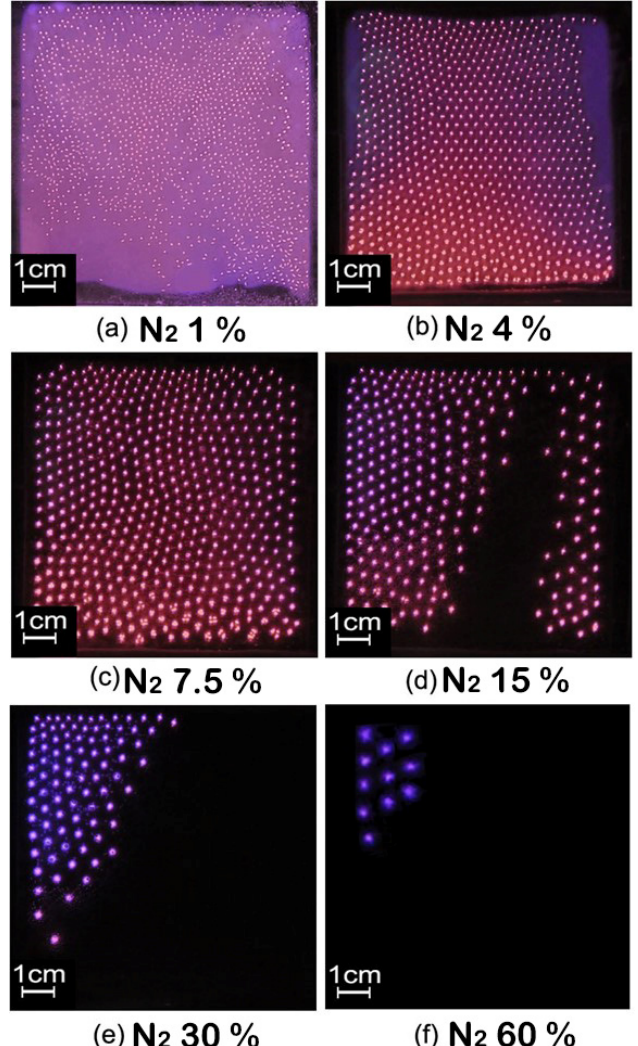
Figure 5. Effect of nitrogen content on self-organizing form of plasma. Exposure time: 1 ms. At 420W, the plasma is extinguished when the nitrogen content is more than